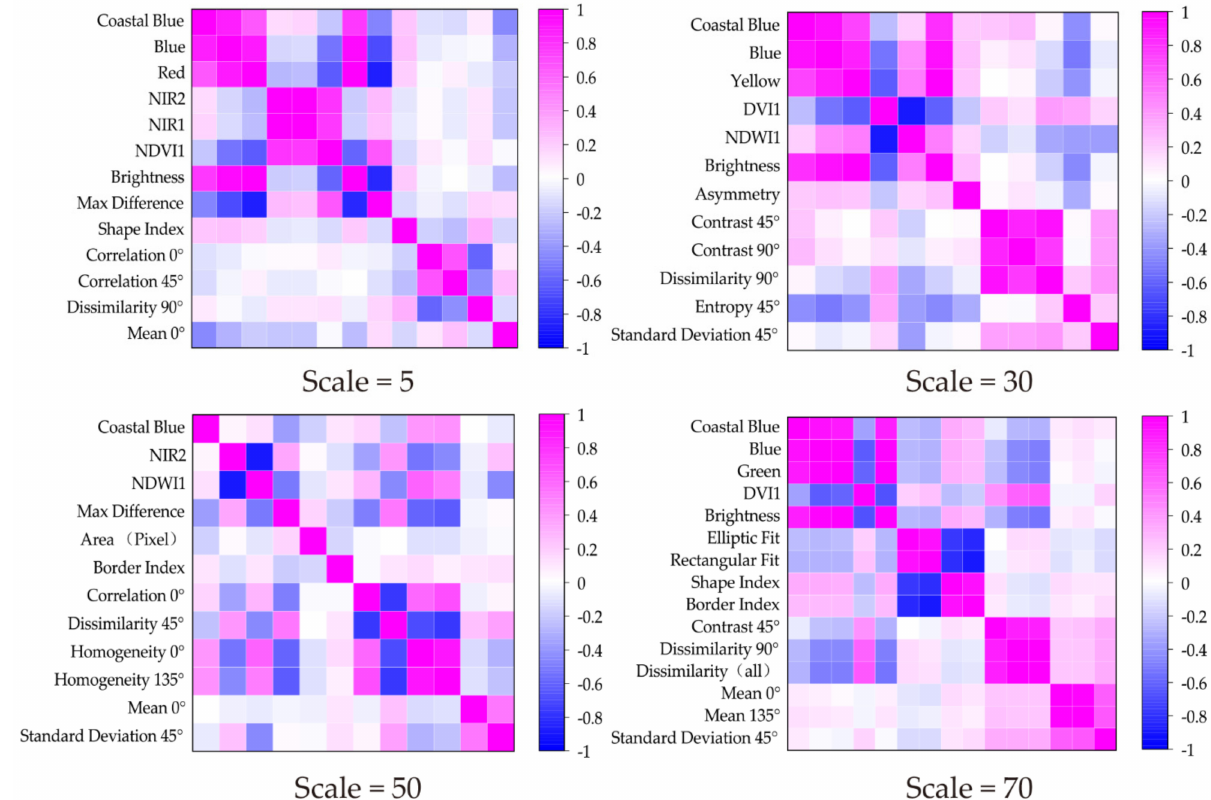
Figure 4. Segmentation objects’ feature correlations for different segmentation